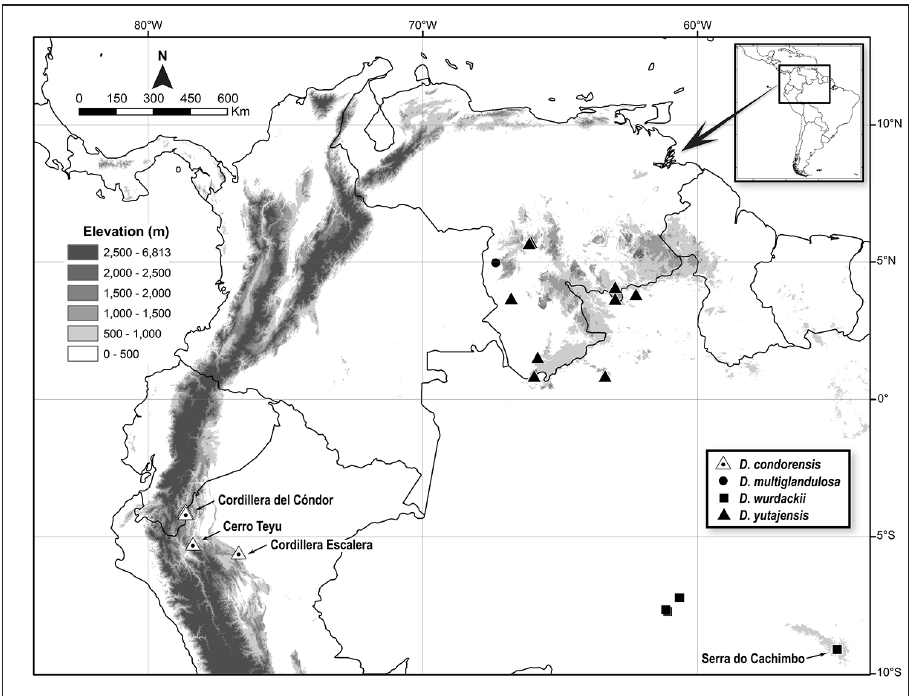
Figure 1. Distribution map of Dendrothrix in northern South Taxonomic treatment Dendrothrix condorensis K.Wurdack, sp. nov.